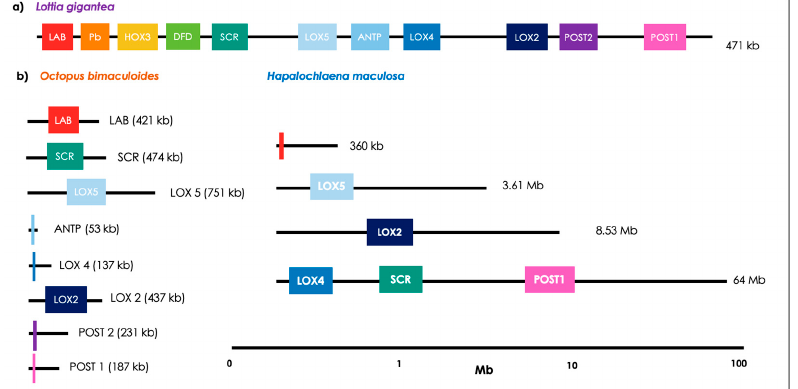
Figure 2. Comparison of HOX gene arrangement in the ( a ) owl limpet ( Lottia gigantea ), ( b ) California Two-Spot Octopus ( Octopus bimaculoides ) and The Southern Blue-Ringed Octopus ( Hapalochlaena maculosa ). Genes are coloured consistently between species. Scaffold lengths for ( b ) follow a logarithmic scale.